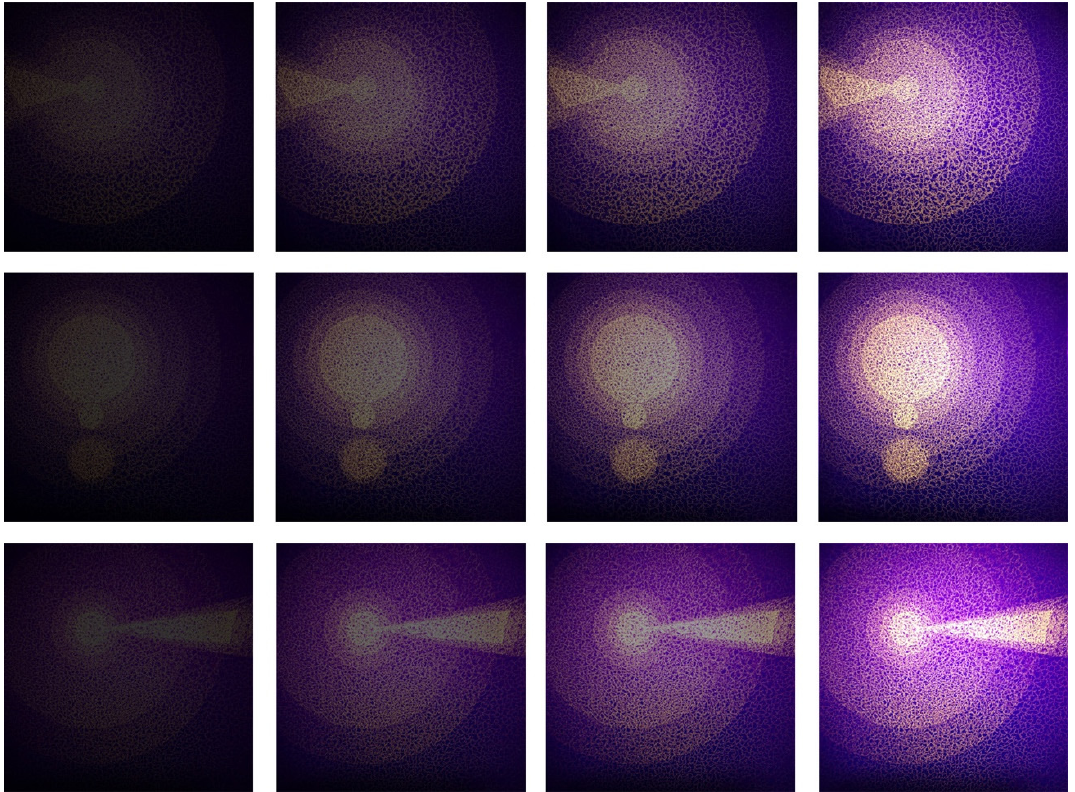
Figure 8. Textures of Light (2020) by Ana Margarida Rocha. Monotypes on Arches BFK Rives black paper. Images viewed through ultraviolet light, with a dimmer-intensity controller. Author’s photos. Figure created by author.